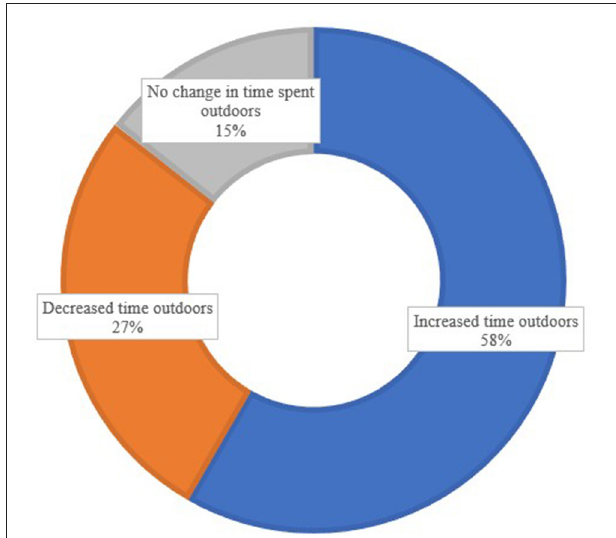
FIGURE 1 | Percentages of participants who reported increased time outdoors, decreased time outdoors or no change spent outdoors since the start of the COVID-19